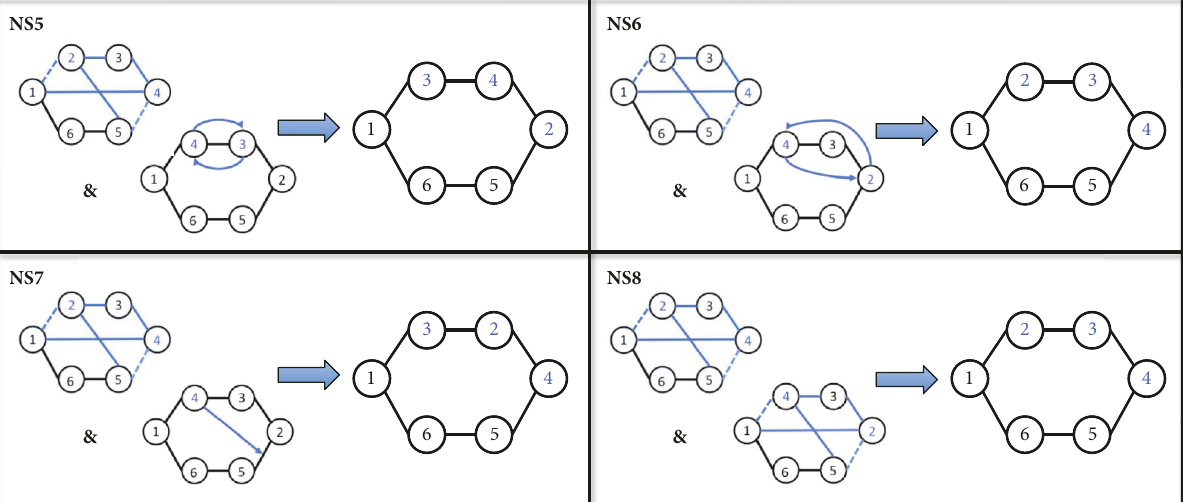
Figure 2: NS5, NS6, NS7, and NS8.